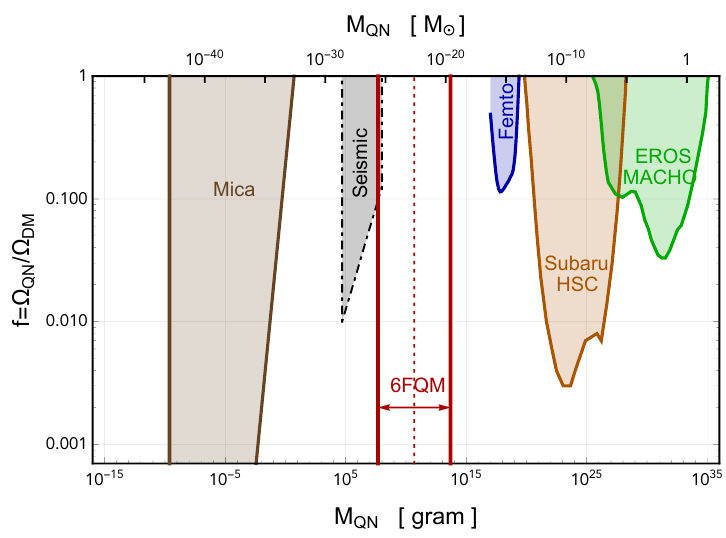
Figure 7 . The preferred mass range of 6FQM together the existing searches for MACHO from mi- crolensing of EROS and MACHO [69] and Subaru/HSC [70] and Femtolensing using Fermi Gamma- ray Burst Monitor (GBM) [72]. Also shown are the constraint from Mica [73] and the tentative limits from moon seismic data [74,